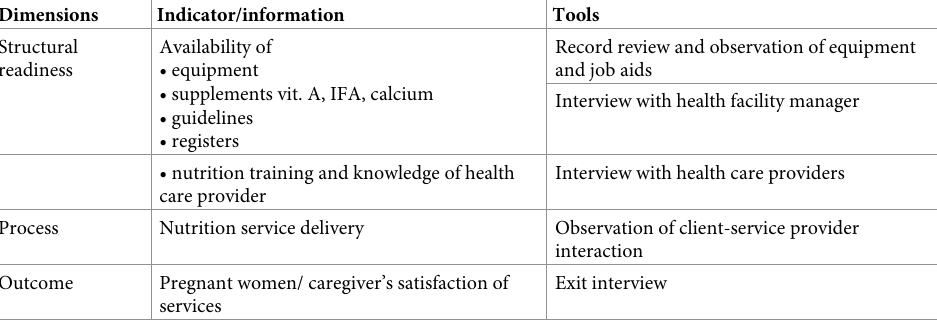
Table 2. Indicators and tools for assessment of the quality of nutrition